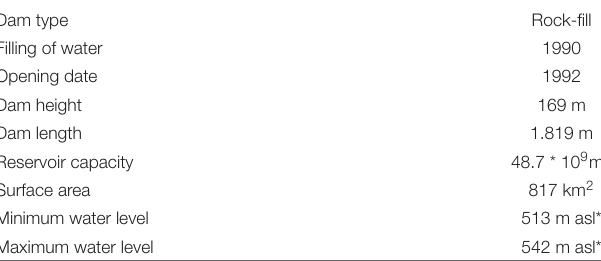
TABLE 1 | The characteristics of Atatürk Dam and its reservoir (The General Directorate of State Hydraulic Works of Turkey; DSI; http://www.ataturkbaraji.com; last accessed April 2021; asl* = above sea